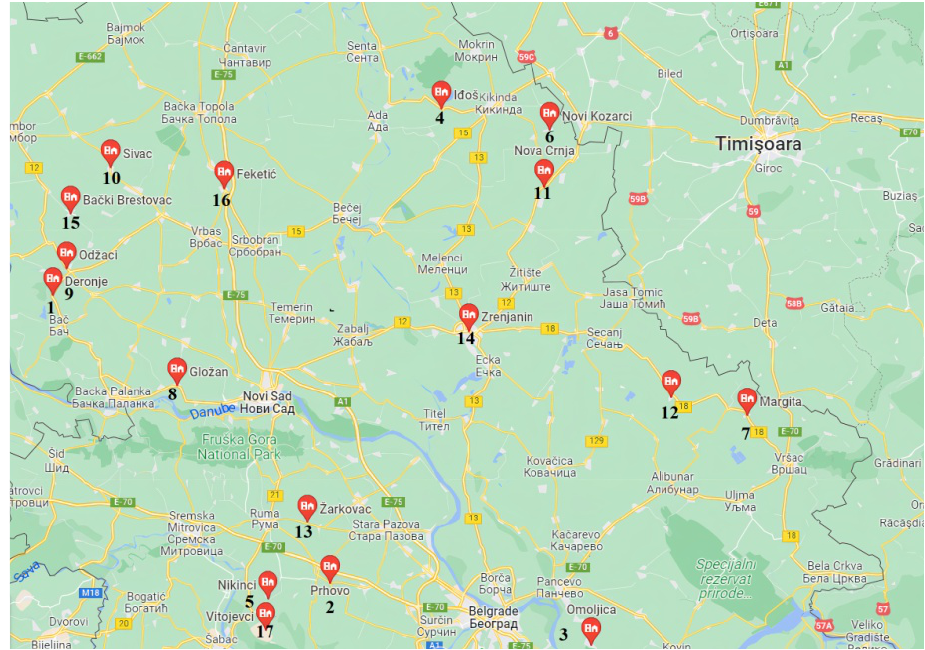
Figure 1. Position of the hunting ground included in the study: 1—Deronje; 2—Prhovo;